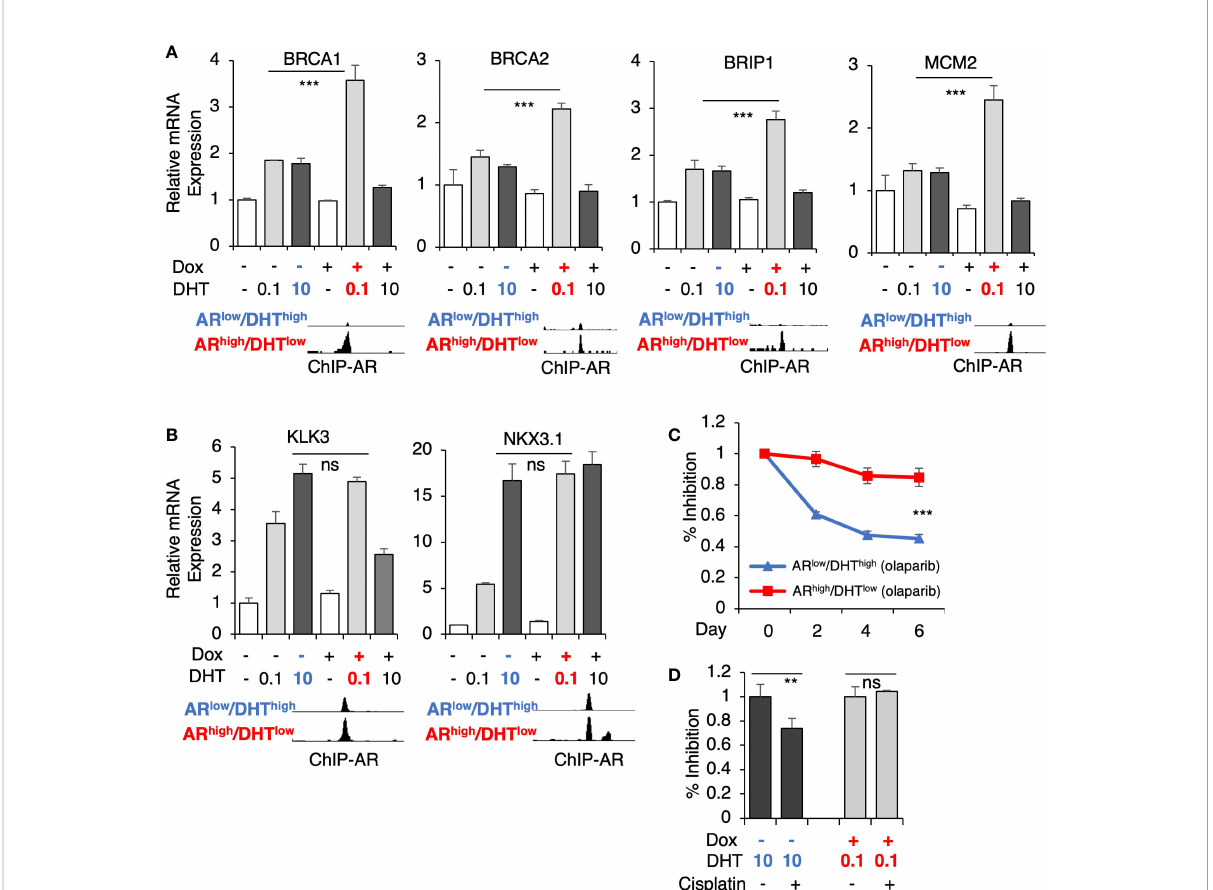
FIGURE 4 AR directly activates genes mediating DNA damage response. (A, B) LNCaP-tet-AR cells were pre-treated with or without 0.25 µg/ml doxycycline for 2d and then stimulated by DHT (0.1 or 10 nM for 24h). mRNA expression of a panel of AR high /DHT low uniquely regulated genes (A) and classic AR-targeted genes (B) were measured. A genome view of AR binding peaks at the target gene loci was also shown for each gene. (C, D) Cell growth inhibition for LNCaP-tet-AR cells under the indicated conditions and treated with or without 10 µM olaparib for 0-6d (C) , or 50 µM cisplatin for 2d (D)